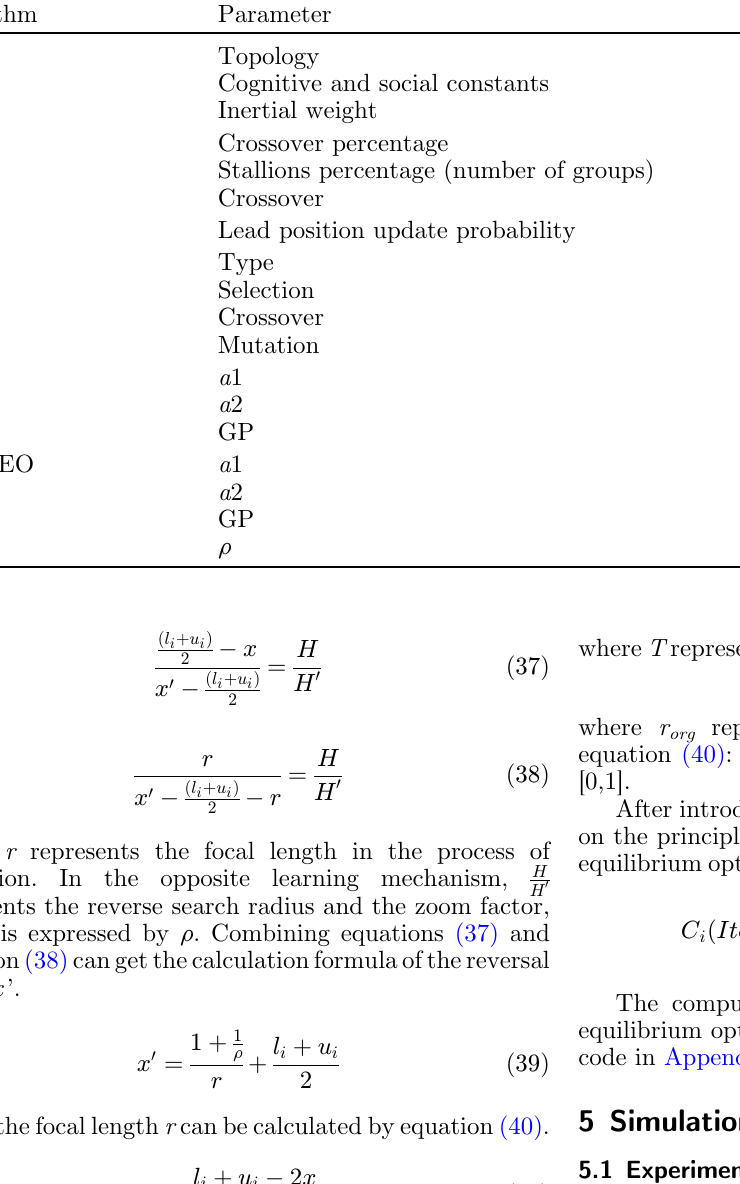
Table 3. Algorithm name and parameter setting.